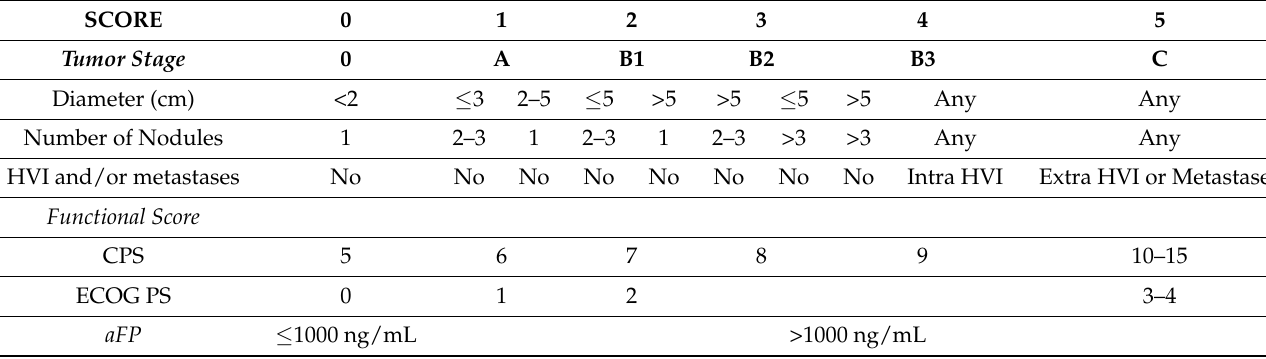
Table 4. ITA.LI.CA prognostic